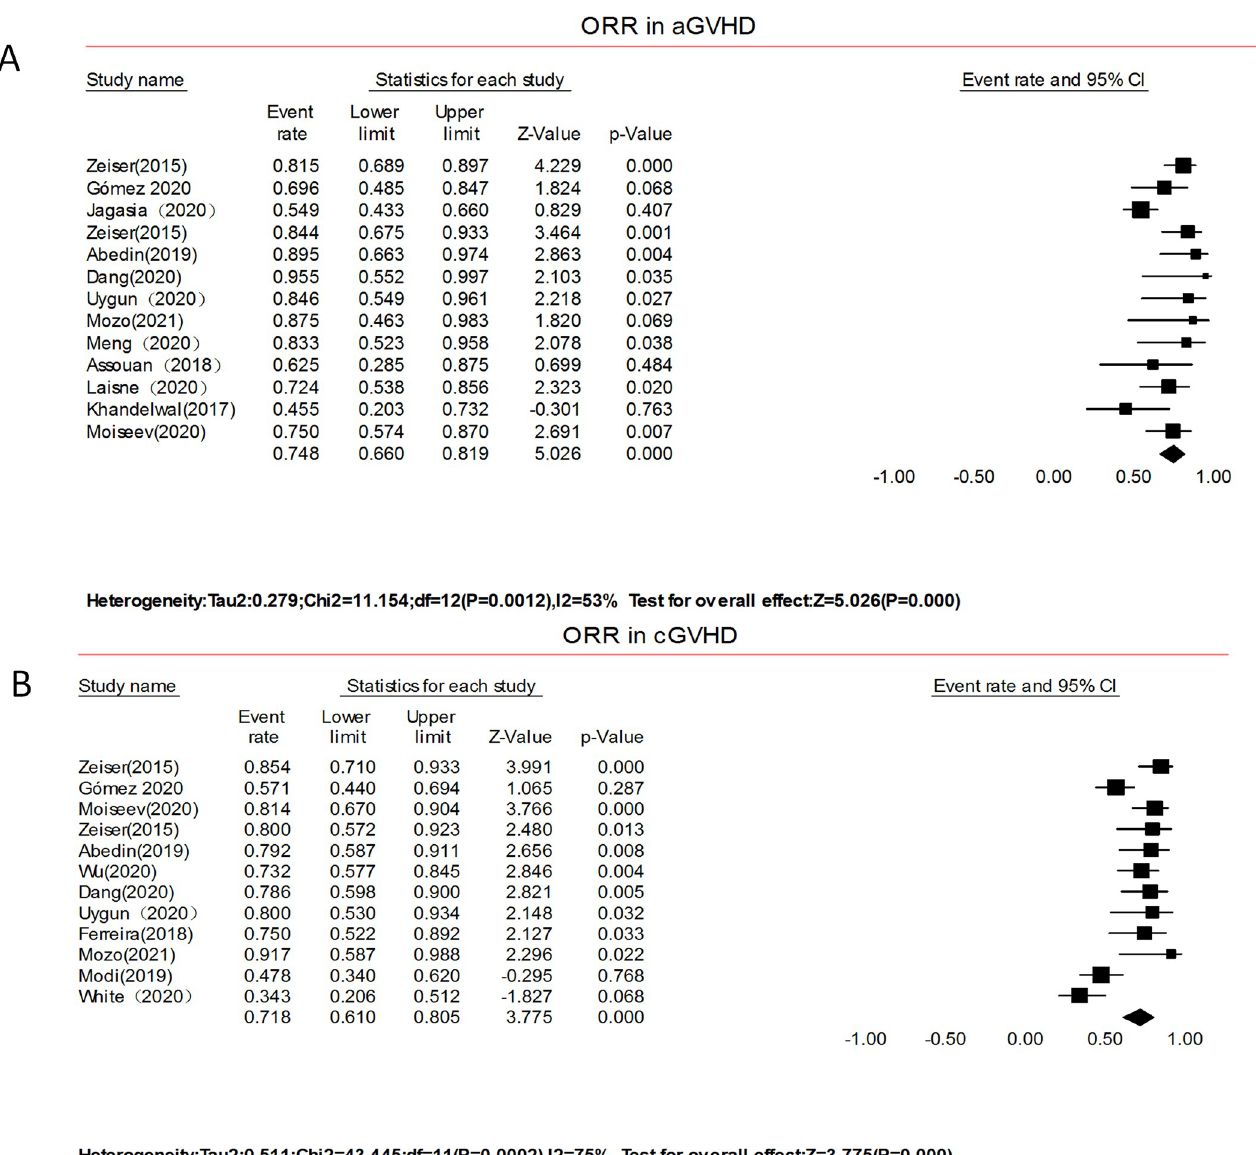
Fig 4. Forest plots of overall